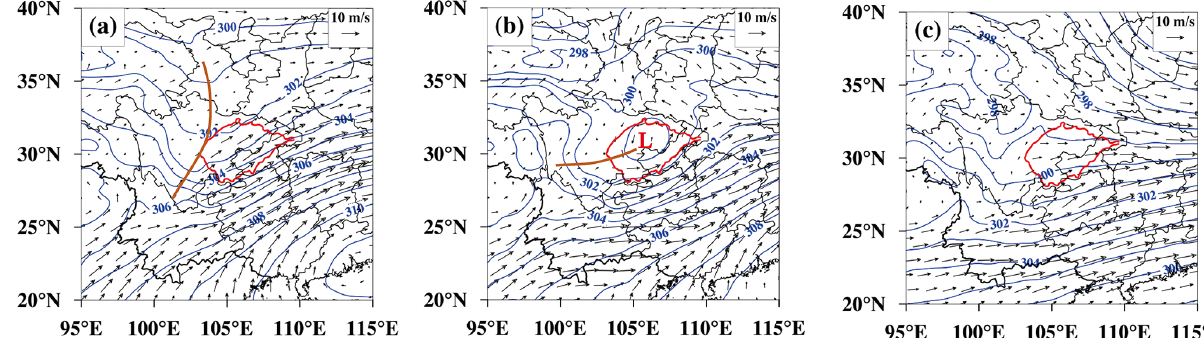
Figure 3. The 700hPa geopotential height fields and wind vectors averaged during (a) P1, (b) P2, and (c) P3 stages with the trough line (brown lines) and low-pressure center (L). The SCB is outlined with red solid lines.